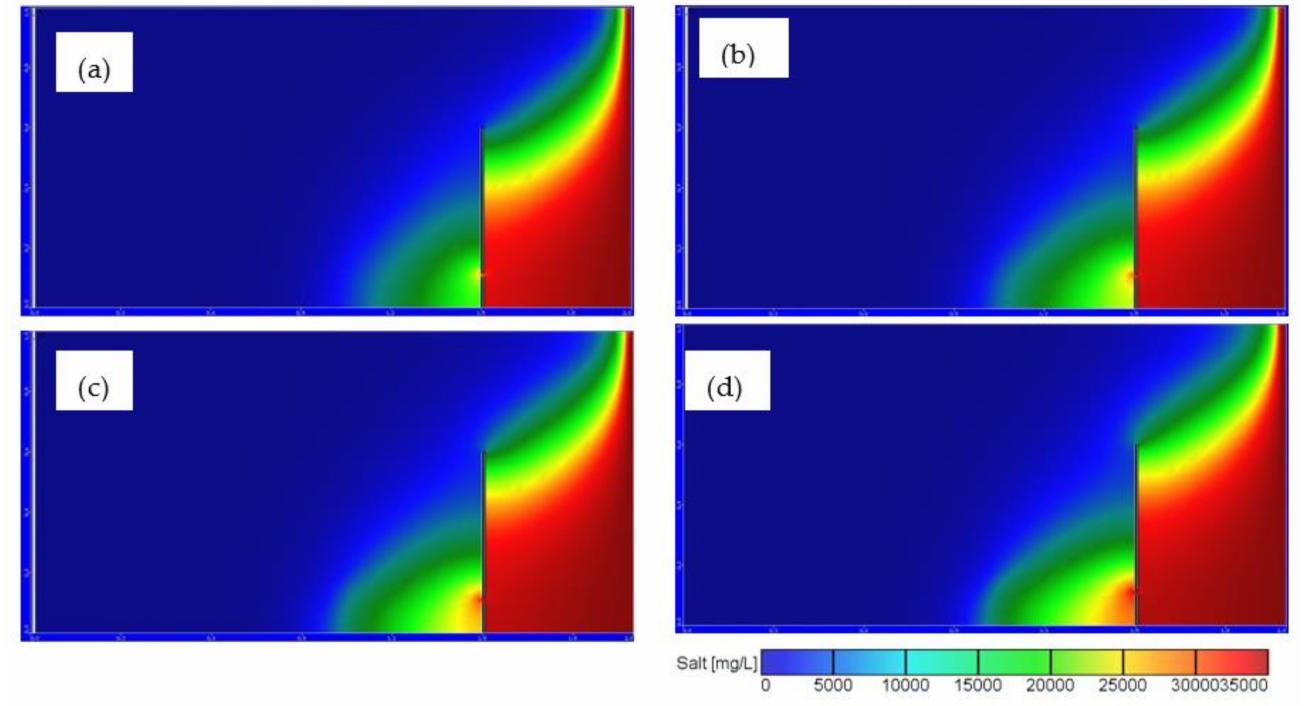
Figure 16. Salinity distribution for D F = 0.005 m, L d = 0.5 m, H w /H d = 0.25 for fracture height H f = 0.1 m and for different values of abstraction rates: ( a ) 2 × 10 − 6 ( b ) 3 × 10 − 6 , ( c ) 4 × 10 − 6 , and ( d ) 5 × 10 − 6 m 3